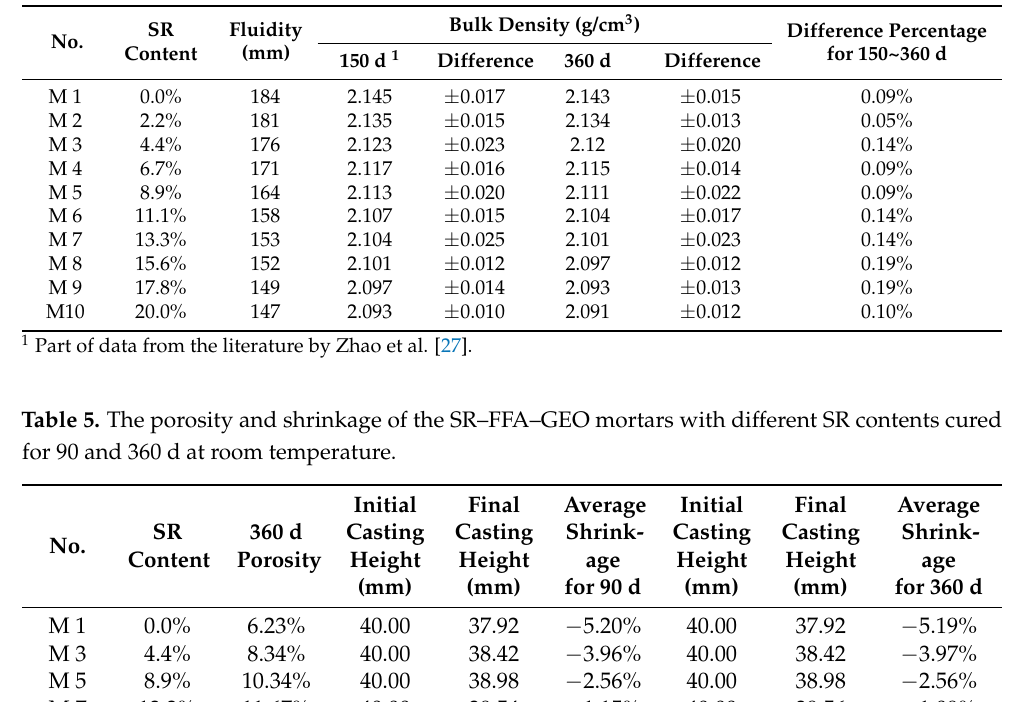
Table 4. The fluidity and bulk density of the geopolymer mortars with different SR contents cured for 150 and 360 d, at room temperature.